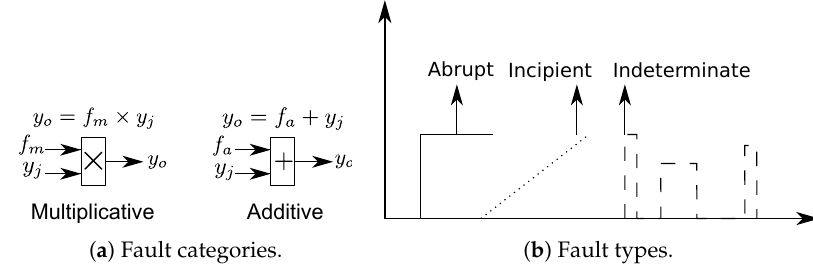
Figure 4. Sensor fault categories ( a ) and types ( b ) (basis from